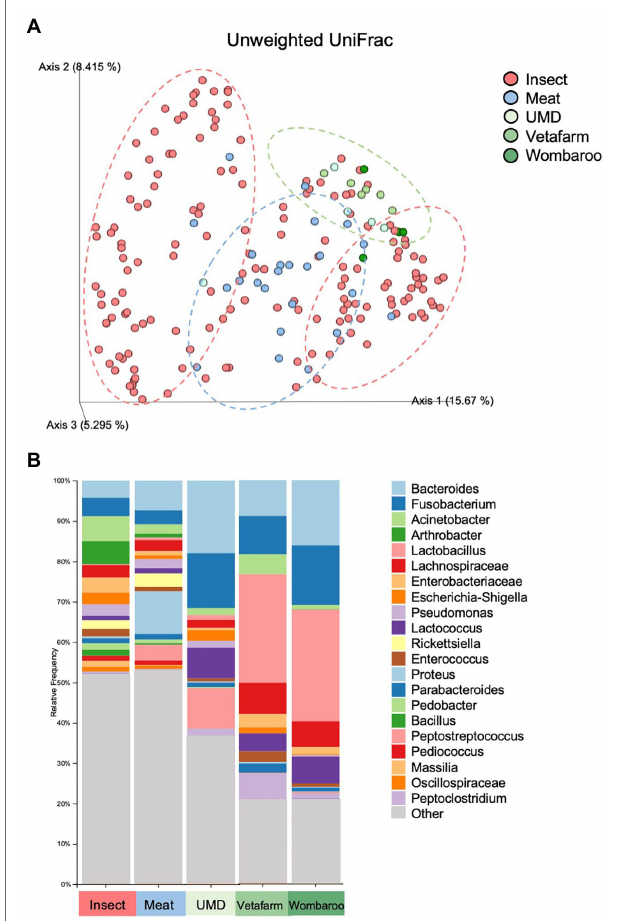
FIGURE 5 | Differences in microbial composition are observed between Meat diet and all other diets fed in captivity. (A) PCoA plot of unweighted UniFrac distances showing separation between Meat diet clustering further to the left of Axis 1 (blue dotted circle) and other diets clustering to the right of Axis 1 (green dotted circle). (B) Taxonomy bar plots showing relative frequencies of bacteria present in echidna scats shown at the phylum level. Samples are labelled by their sample ID and diet ( Supplementary Figure S2 ). Most prevalent phyla are included in the legend; as bar colours repeat, the legend is labelled with most abundant taxa on top to least abundant taxa on bottom of legend. UMD, Updated Meat Diet. Original and interactive QZV files to view bar plots are available in Supplementary Files